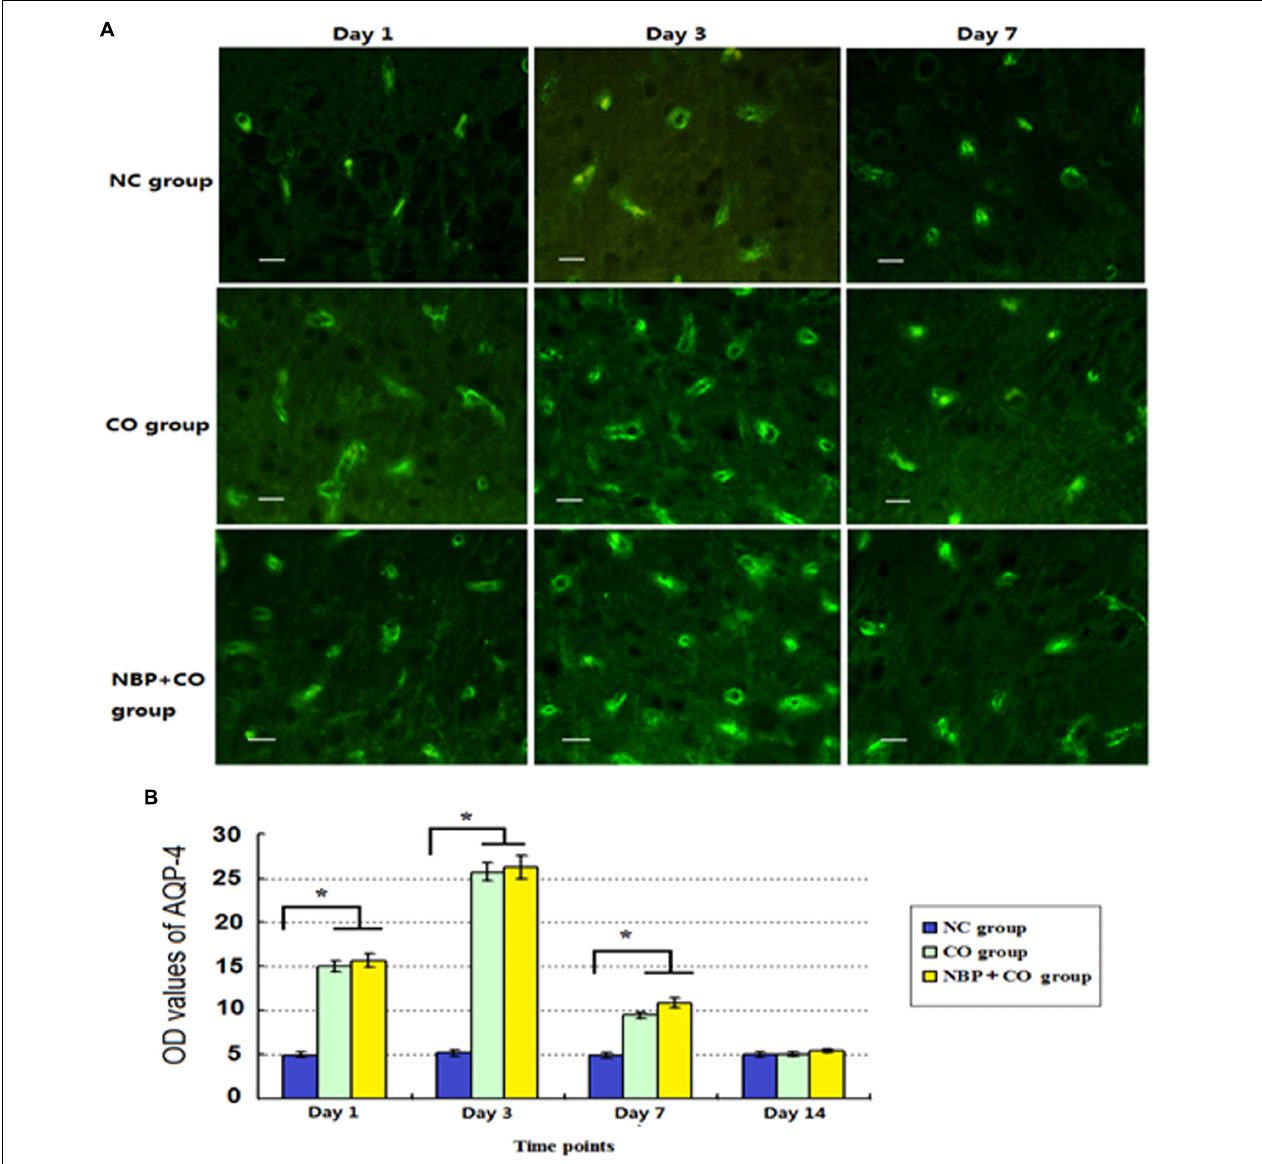
FIGURE 7 | The OD value alterations of AQP-4 expression in NC, CO, and NBP + CO groups. A small amount of AQP-4 positive cells scattered in brain tissue in normal rats. After exposure to CO, AQP-4 expression was temporarily elevated and then gradually decreased. NBP treatment caused a slightly higher expression of AQP-4 protein compared to that in CO group, whereas it lacked a statistically significant difference between the two groups ( n = 4, P > 0.05). (A) The expressions of AQP-4 positive cells in each group; (B) The OD value alterations of AQP-4 positive cells in different groups ( n = 4). ∗ Compared with NC group ( n = 4, P < 0.05 ( F = 10.621 ∼ 56.349). Scale bar = 30 µ